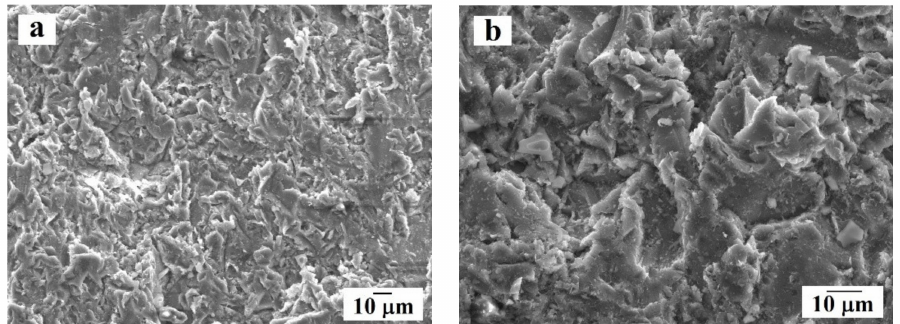
Figure 1. Surface morphology of the aluminum alloy substrate after sandblasting at different magnifications: ( a ) overview; ( b ) enlarged